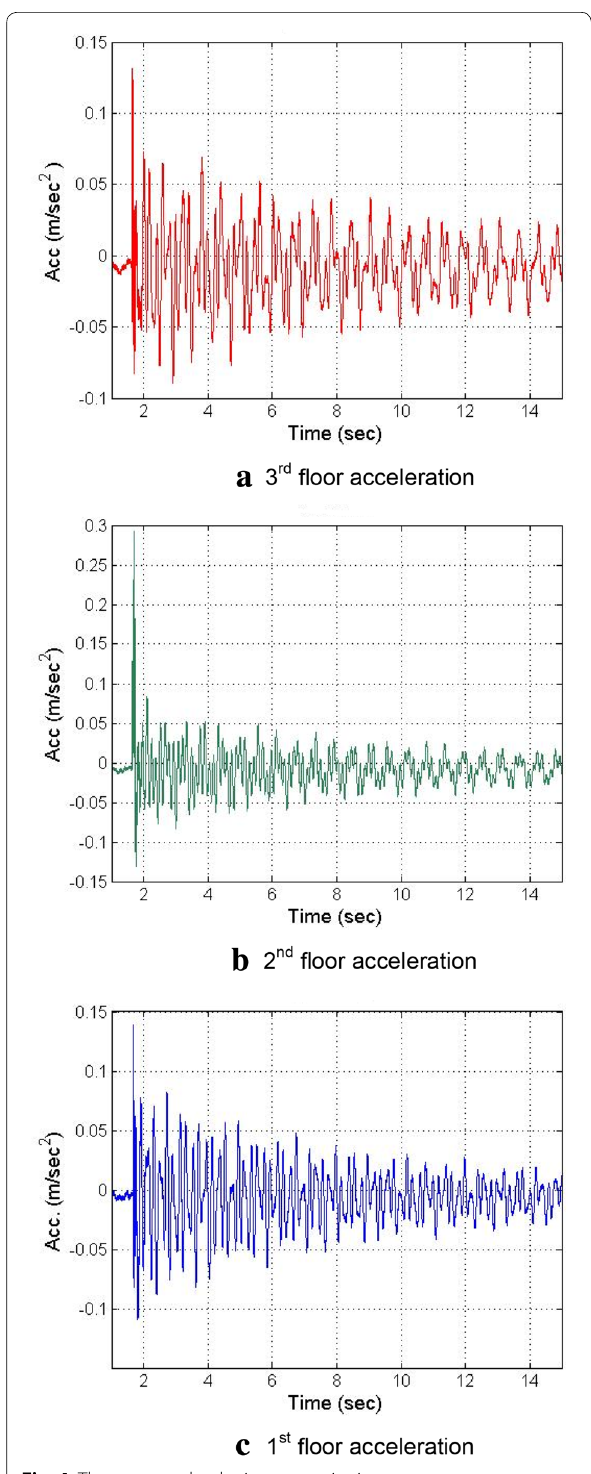
Fig. 4 The response by the impact